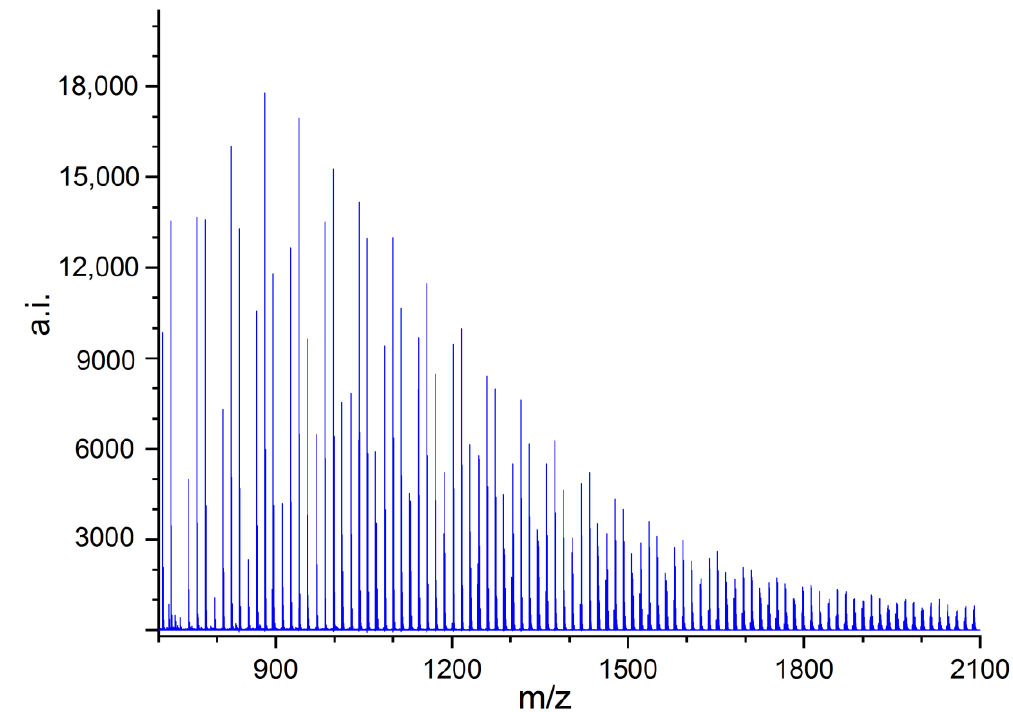
Figure 5. Matrix-assisted laser desorption/ionization time-of-flight (MALDI-TOF) MS spectrum of OECHD in the range m/z = 700–2100.